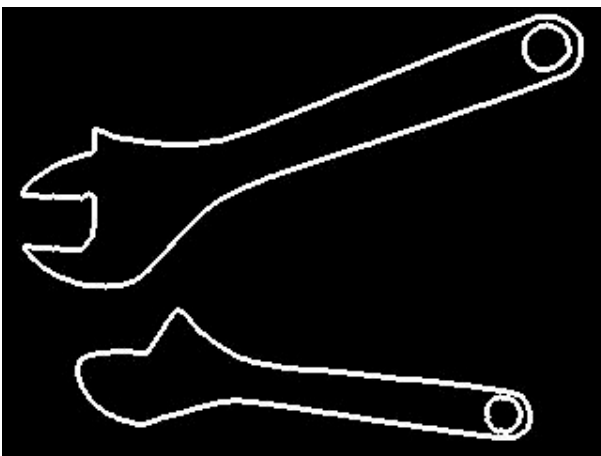
Figure 1. Shape differences between images of the same object. Figure 1. Shape di ff erences between images of the same